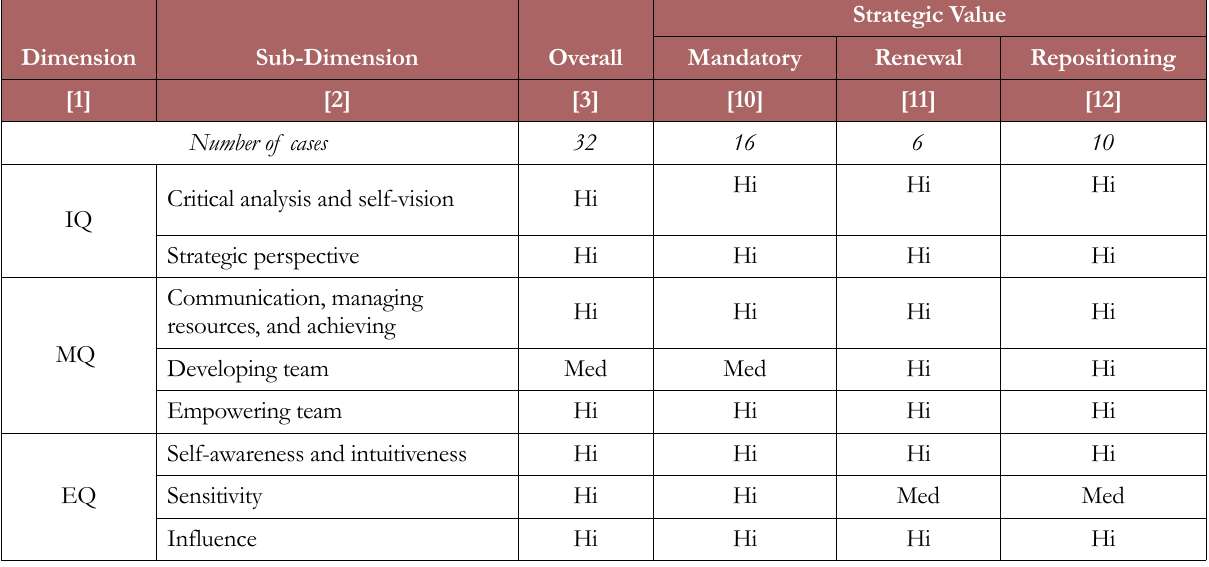
Table 6. Leadership Competency Map for More Successful Projects (Strategic Value as a Moderating Variable)